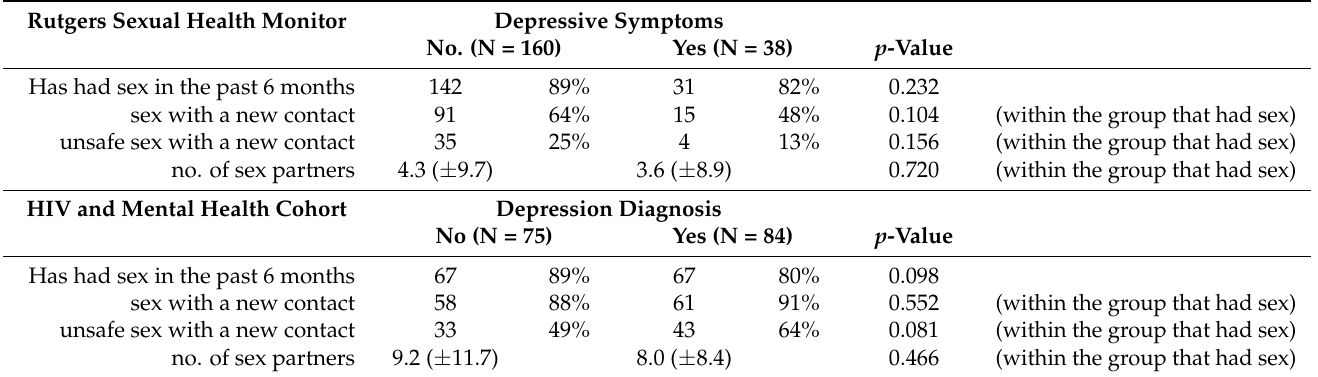
Table 2. Comparison of sexual contacts between subjects with and without depressive symptoms or diagnosis performed separately within the two study populations.